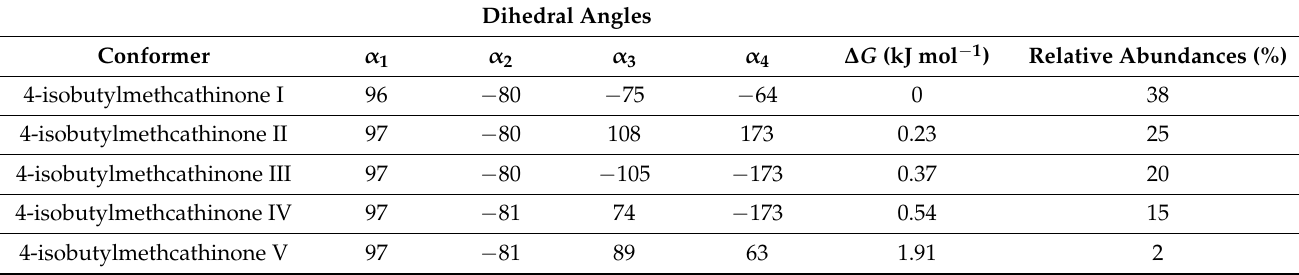
Table 1. Structural parameters of the most stable conformers of 4-isobutylcathinone: the values of dihedral angles α 1 , α 2 , α 3, and α 4 , relative Gibbs free energies, and relative abundances based on the Boltzmann distribution. The calculations were performed at the B3LYP/6-311++G(d,p) level. Dihedral